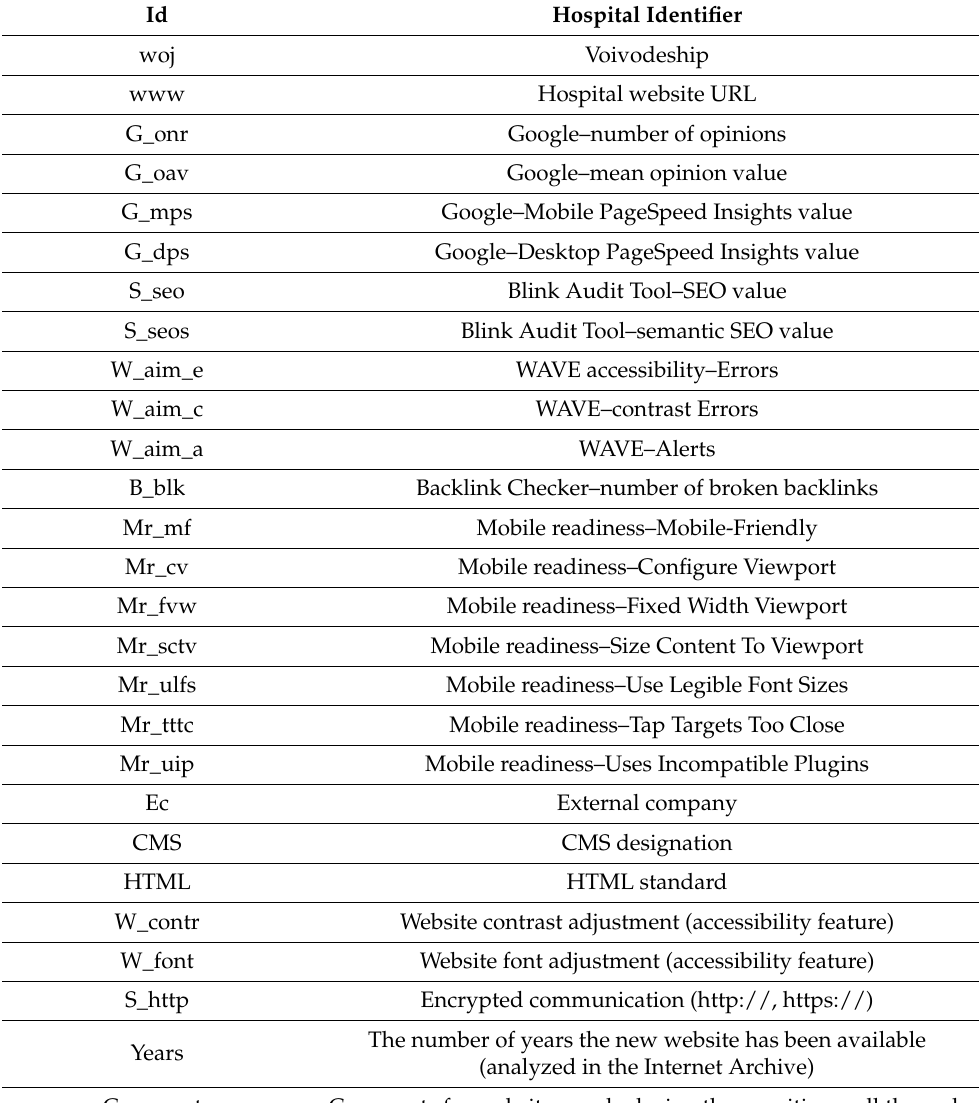
Table 2. List of attributes and their symbols.